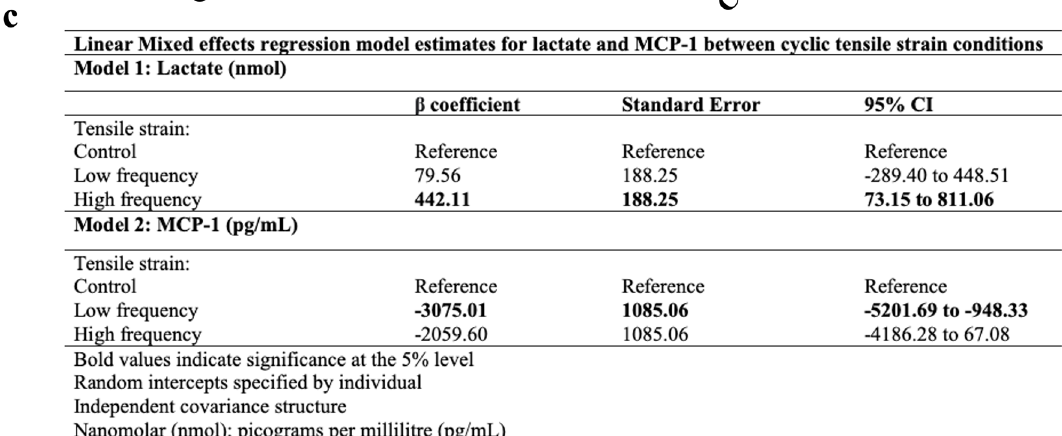
Figure 2. Lactate and MCP-1 release into conditioned media from synovial tissue. ( a ) Dot plot displaying the individual lactate measures as well as the mean ± 95% CI of lactate for Control (black), Low (light blue), and High (dark blue) strain conditions. ( b ) Dot plot displaying the individual MCP-1 measures as well as the mean ± 95% CI of lactate for Control (black), Low (light blue), and High (dark blue) strain conditions. ( c ) Linear mixed effects model estimates for lactate (Model 1) and MCP-1 (Model 2) in conditioned media for each cyclic tensile strain condition. CI, confidence interval; nmol, nanomolar; pg/mL, picogram per